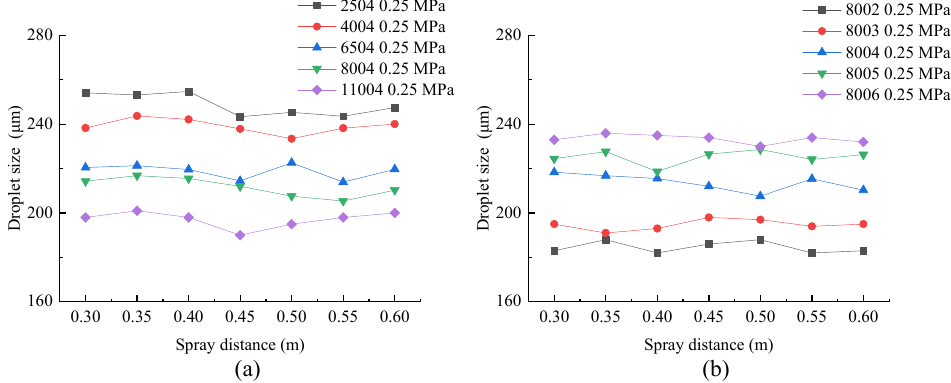
Figure 5. Graph of droplet size vs. spray distance: ( a ) different spray angles; and ( b ) different flow rates. As can be seen in Figure 6, the droplet size along the Z-axis gradually decreased with the increase in the spray pressure. According to the Bernoulli equation, the droplet veloc- ity at the nozzle outlet increases with the increase in the spray pressure, causing the liquid film to break to produce smaller droplets. The fitting function between the droplet size along the Z-axis and the spray pressure is represented as follows: 1 3 z D